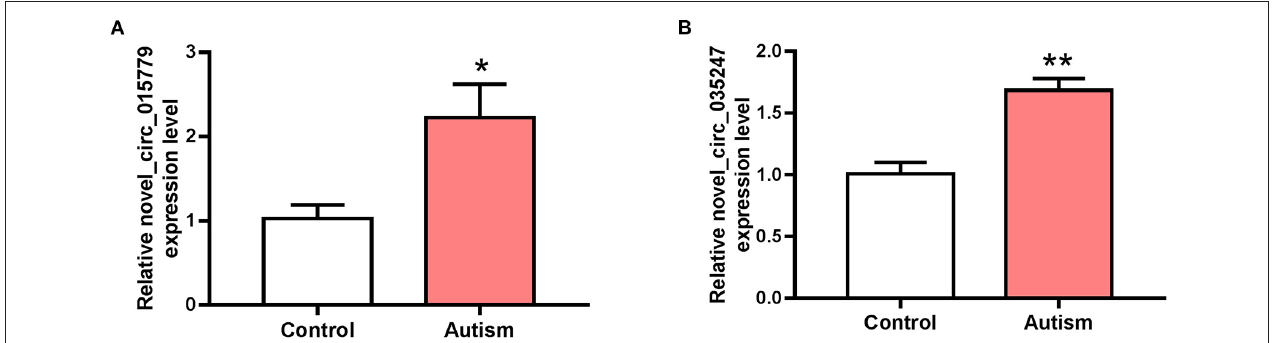
FIGURE 3 | The expression of novel_circ_015779 and novel_circ_035247 in control and autism groups. (A) The expression of novel_circ_015779. (B) The expression of novel_circ_035247. * P < 0.05, ** P < 0.01 vs. Control, n = 3.